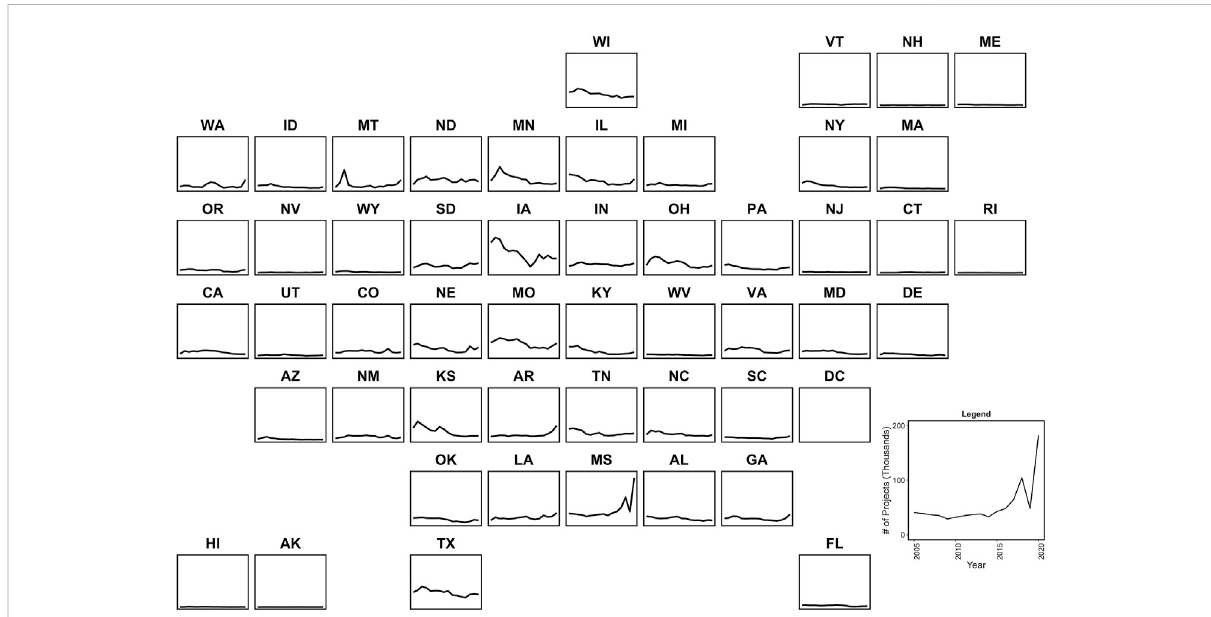
FIGURE 3 Changes in the spatial distribution of projects (i.e., practice counts) in USDA RCA programs among states over time. The inset legend (bottom right) describes the axes used for all state plots, and uses data from the state of Mississippi (MS) as an example. State abbreviations follow ANSI two- letter codes and are arranged in each state ’ s approximate geographic